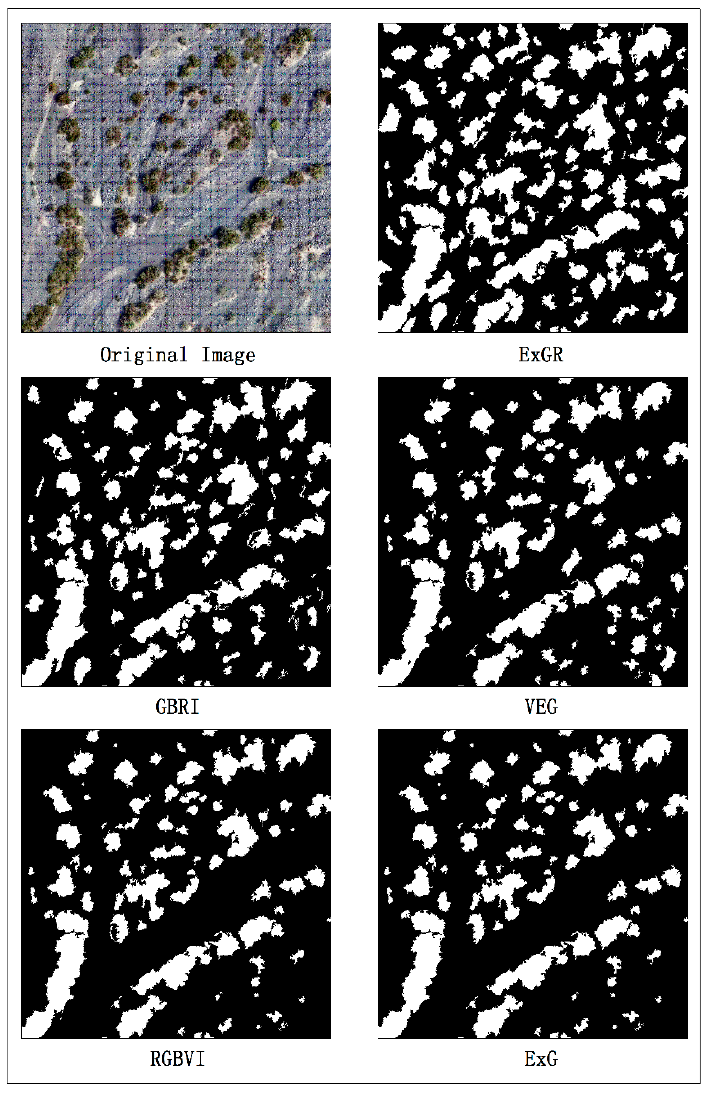
Figure 6. Results of extraction using different vegetation indices in the Gobi region (30 × 30 m). The white color is vegetation area, and black is non-vegetation area. Abbreviations: excess green red index (ExGR), green blue ratio index (GBRI), vegetative index (VEG), red green blue vegetation index (RGBVI), excess green index (ExG). Table 2. Accuracy evaluation of vegetation extraction from different vegetation index images.